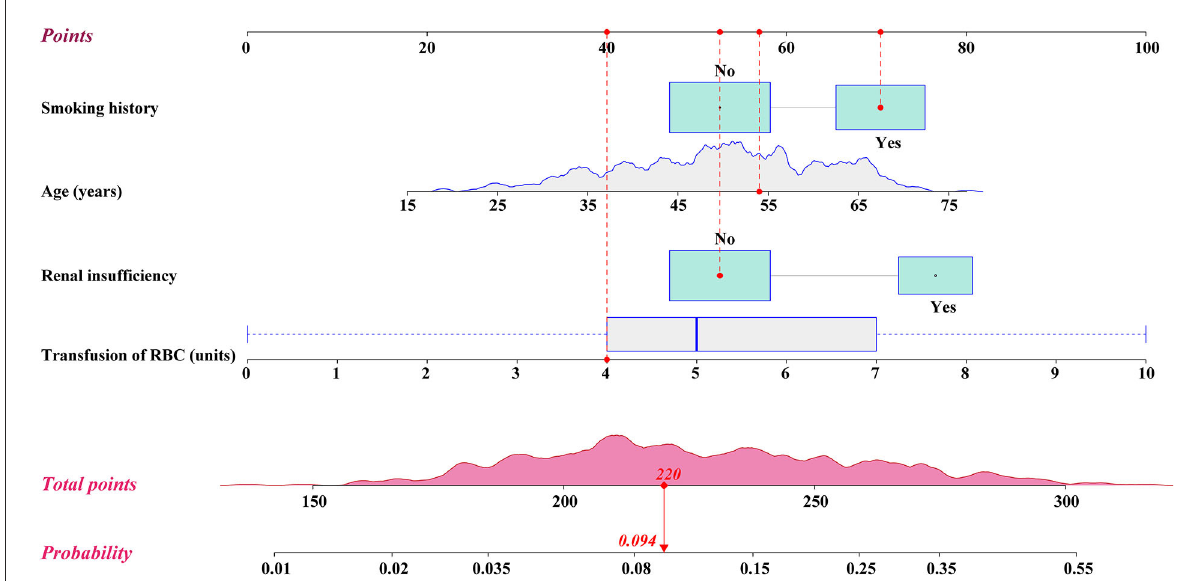
FIGURE1 Nomogram for the prediction of postoperative reintubation in patients undergoing AADS. A specific patient was shown to illustrate how to use the nomogram. This was a 54-year-old patient who had smoking history, normal renal function, and was transfused 4 units of RBCs intraoperatively. The individual item point corresponding to each factor is presented at the top, and the total scores were obtained from the sum of the points corresponding to each factor by a red dot. Given values of the 4 predictors, the patient can be intuitively mapped onto the nomogram. It can be clearly seen from the nomogram that the total scores of this patient was 220 points and the corresponding probability of reintubation was 0.094. AADS, Stanford type A acute aortic dissection surgery; RBC, red blood